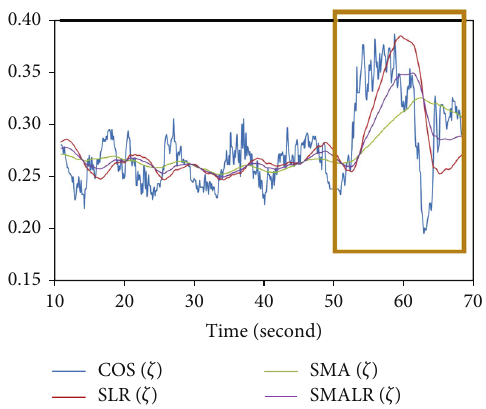
Figure 10: Raw cosine roll angle λ versus fi ltering algorithms (round